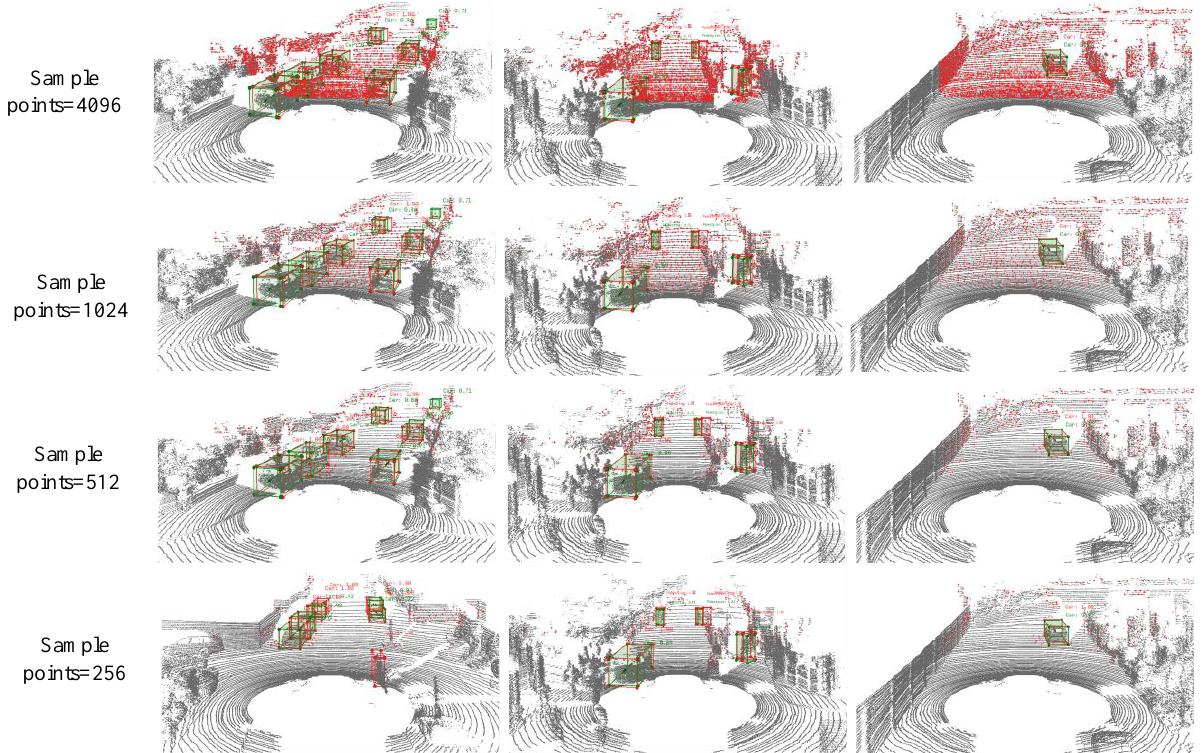
Figure 7. Qualitative visualisation of the downsampled point clouds achieved at different sampling stages.